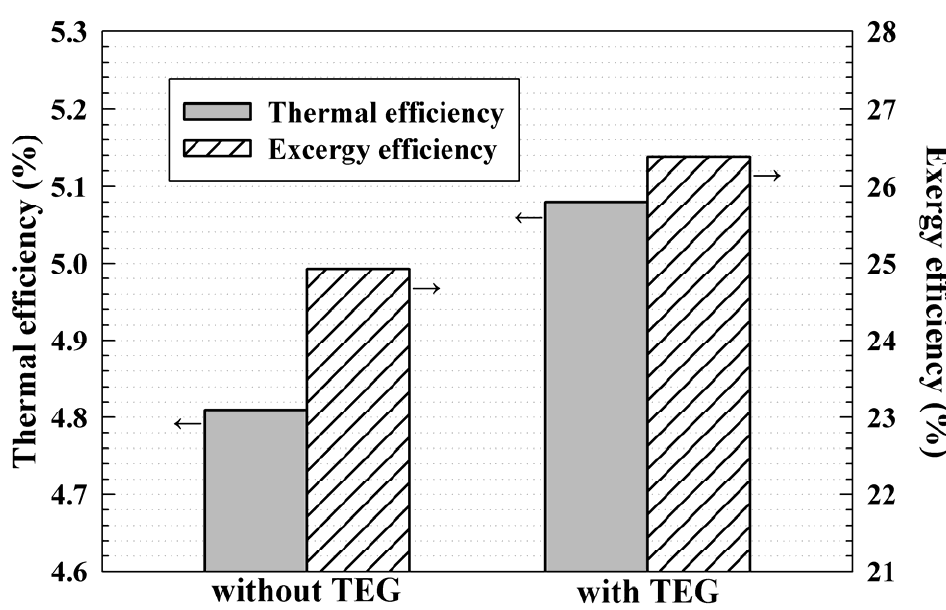
Figure 12. Comparison of thermal and exergy efficiency of the ORC based on the application of the proposed TEG.